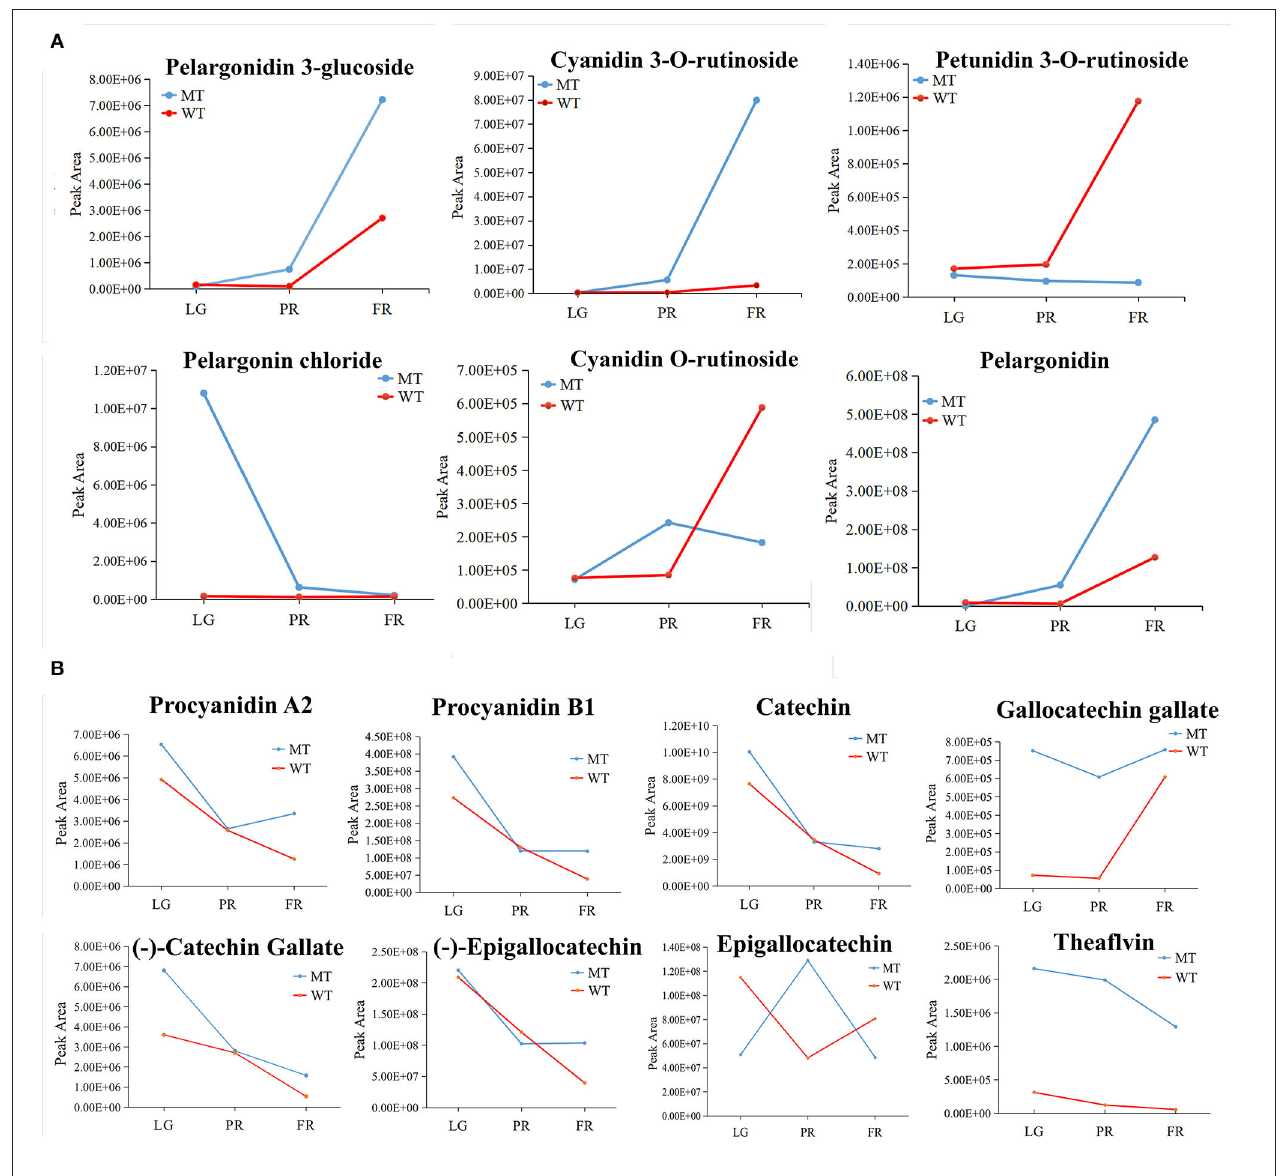
FIGURE 5 | The change patterns of individual differentially accumulated anthocyanins (A) and PAs (B) during the fruit development in MT and WT samples. LG, PR, and FR indicated the large green, partial red, and fully red stages.